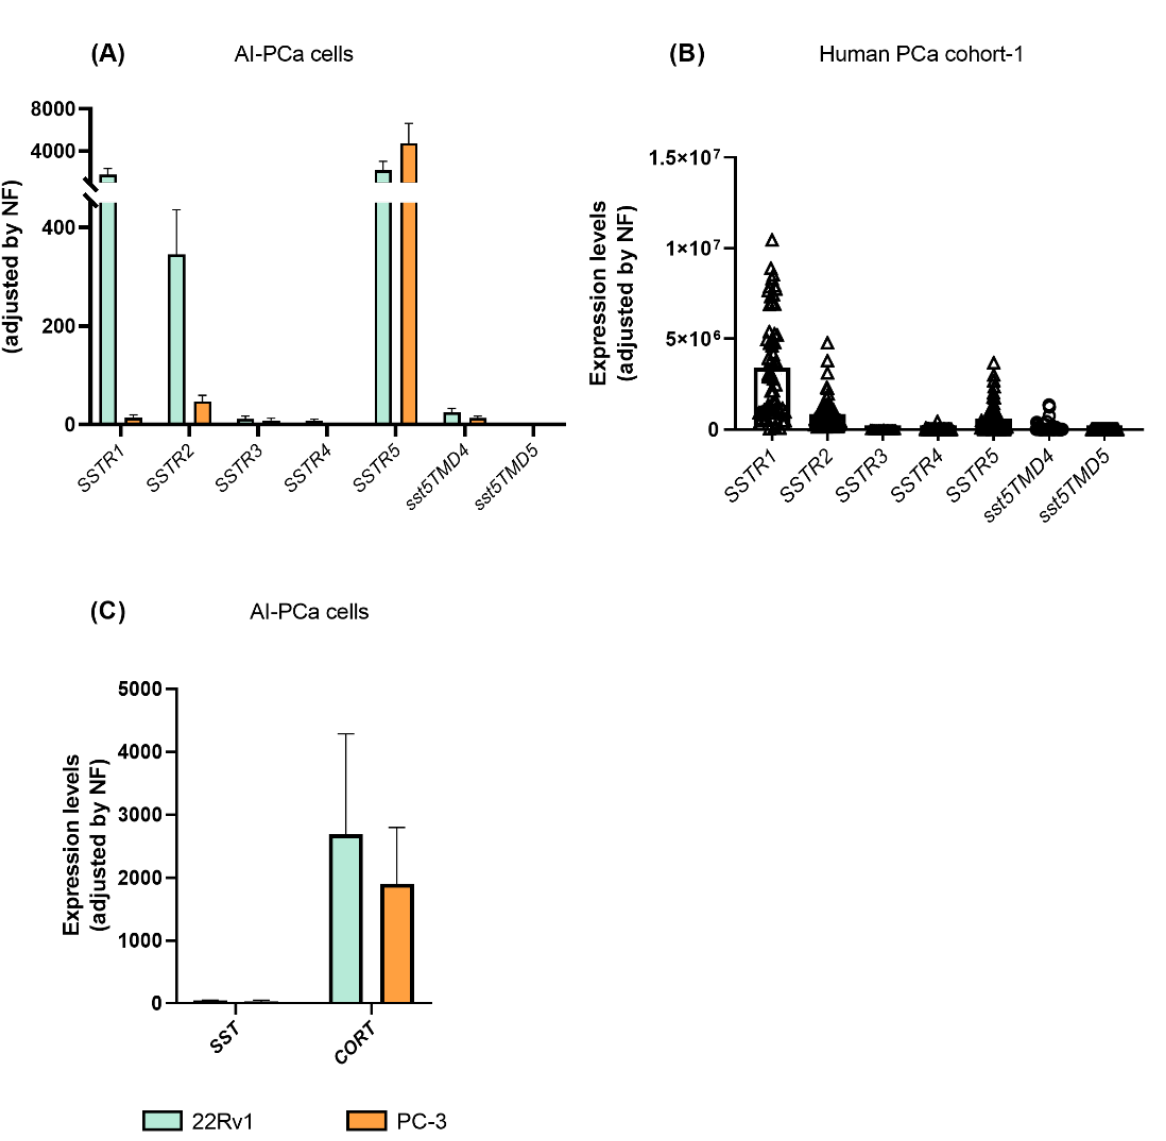
Figure 3. Expression profile of somatostatin-system [receptors (SSTRs), and ligands (somatostatin-SST and cortistatin-CORT)] in androgen-independent (AI) prostate cancer (PCa) cells and fresh prostate tissue ( n = 69; cohort-1). ( A ) Expression of SSTRs in 22Rv1 and PC-3 AI-PCa cells. ( B ) Expression of SSTRs in PCa fresh samples. ( C ) Expression of SST and CORT in AI-PCa cells. Data represent the mean of mRNA copy number ± Standard Error of the Mean (SEM). mRNA levels were determined by quantitative polymerase chain reaction and adjusted by normalization factor